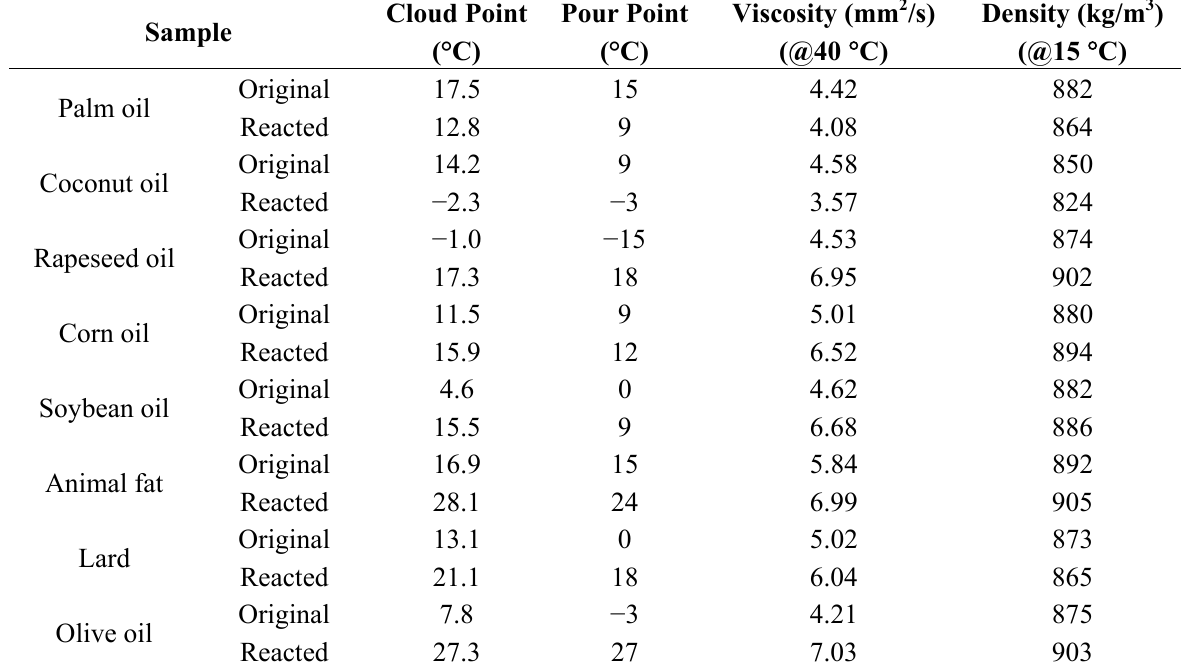
Table 3. Effect of isomerization/hydroisomerization reactions on fuel